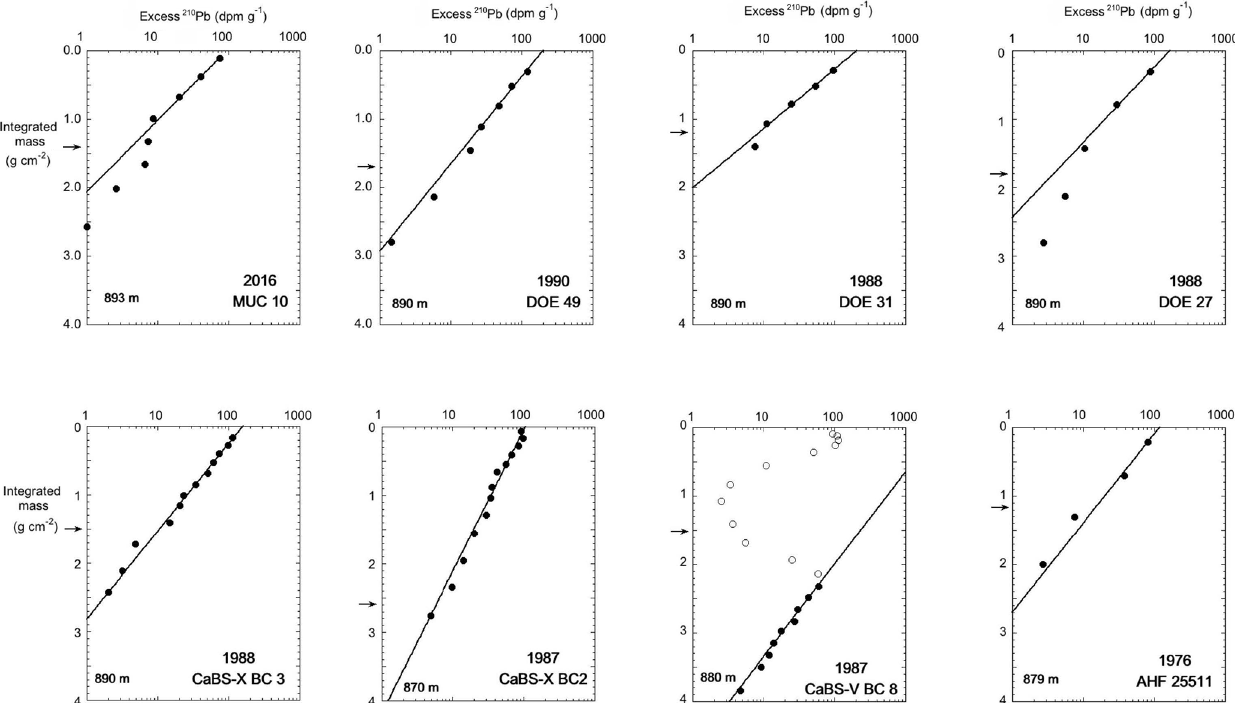
Figure 12. The same as Fig. 11 but for 8 cores obtained from depths between 870–900m.